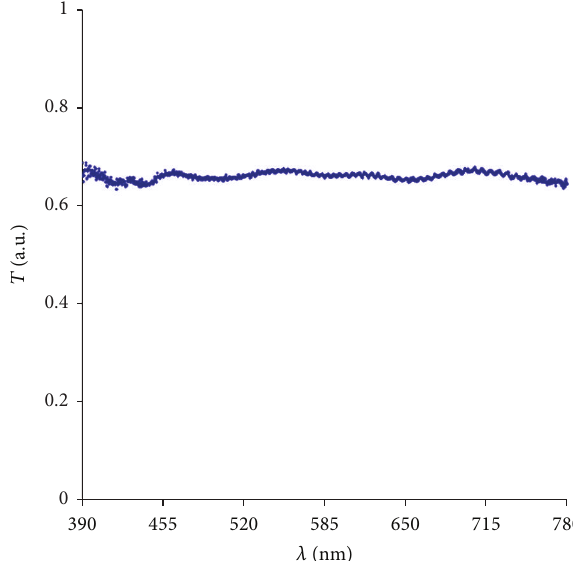
Figure 6: Measured transmittance spectrum of the 70% neutral density filter.